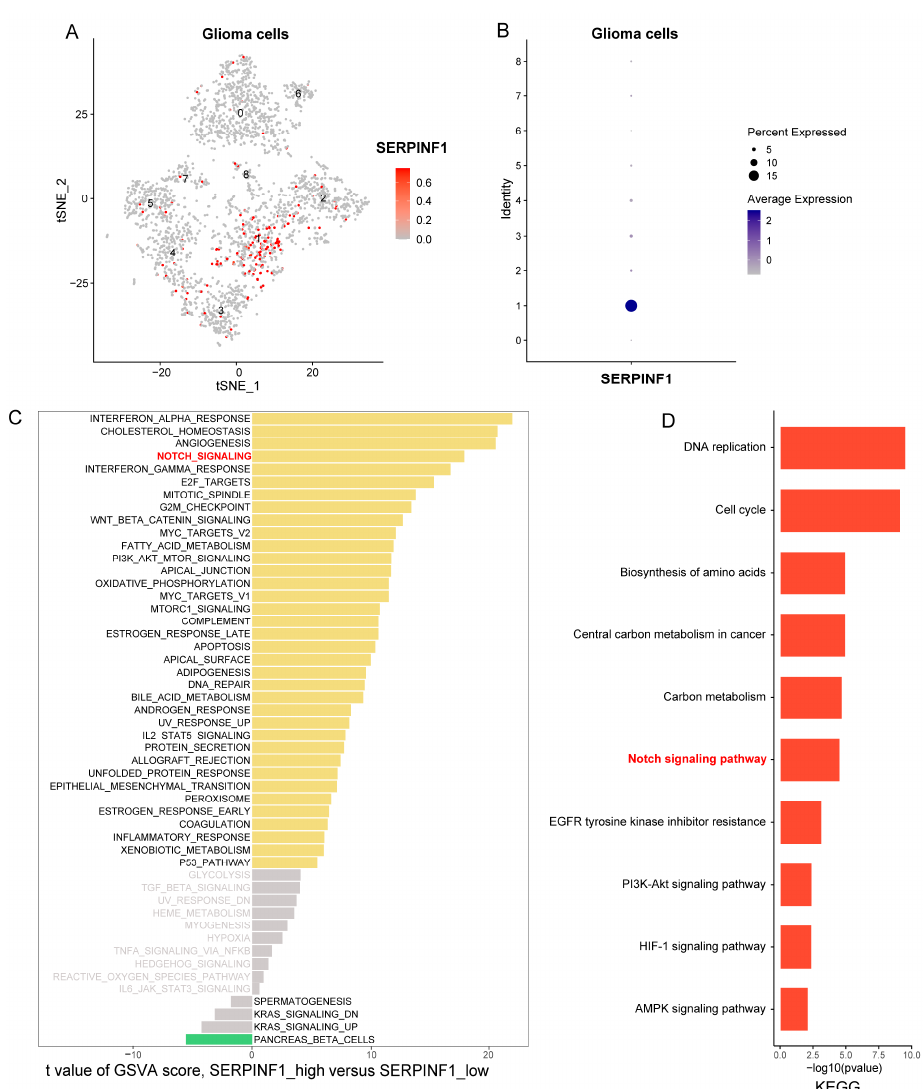
Figure 6. The signaling pathways associated with SERPINF1 expression at the single-cell level. ( A ) tSNE plot of the 2751 glioma cells with each cell color-coded based on the expression of SER- PINF1. ( B ) SERPINF1 expression in nine subclusters of glioma cells visualized in a bubble plot. ( C ) Differences in pathway activities scored per cell via GSVA between high- and low-SERPINF1 clusters. ( D ) Signaling pathways enriched in high-SERPINF1 cluster based on KEGG analysis at the single-cell